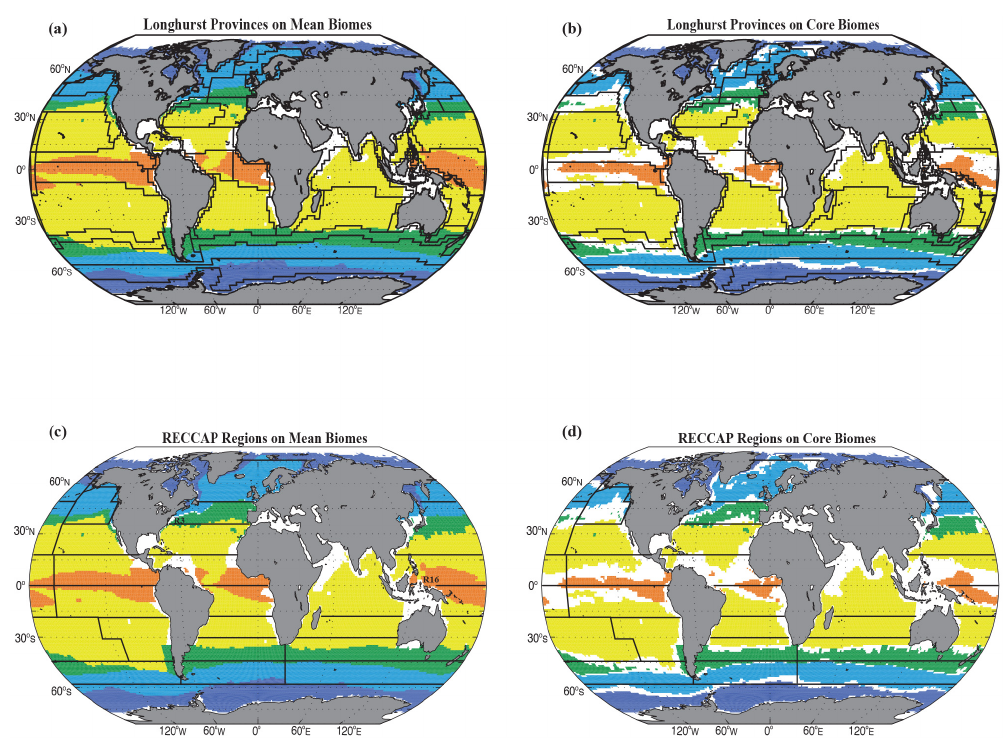
Figure 6. Longhurst’s 56 provinces overlaid on top of (a) mean biomes and (b) core biomes; RECCAP ocean regions overlaid on top of (c) mean biomes and (d) core biomes. RECCAP regions 3 and 16 are labeled to facilitate interpretation of Fig.